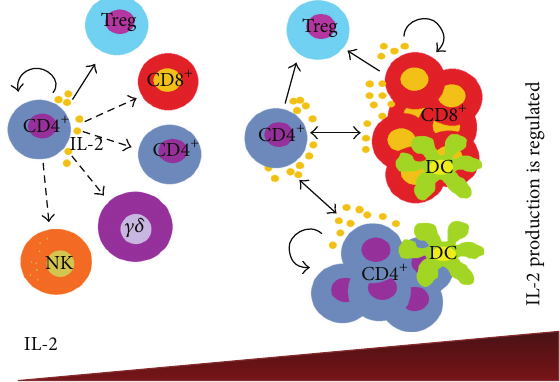
Figure 3: IL-2 concentration and homeostasis. Under steady state conditions, interleukin 2 is primarily produced by activated T cells, particularly CD4 + T cells. Then, the secreted IL-2 is consumed by Treg cells and adjacent activated CD4 + , CD8 + , and 𝛾𝛿 T cells and NK cells (cells with functional high-affinity IL-2 receptors). Binding of IL-2 to its receptor initiates activating and/or mitogenic signals and induces the differentiation of na¨ıve T cells into effector and memory T cells. The survival of Ag-selected T cells is essential for the maintenance of Treg cells. Additionally, DCs are able to produce IL-2 in response to the recognition of some pathogen-associated molecular patterns, which favours the proliferation of specific T cells. IL-2 production is regulated by silencing the IL-2 gene to prevent the apoptosis of these